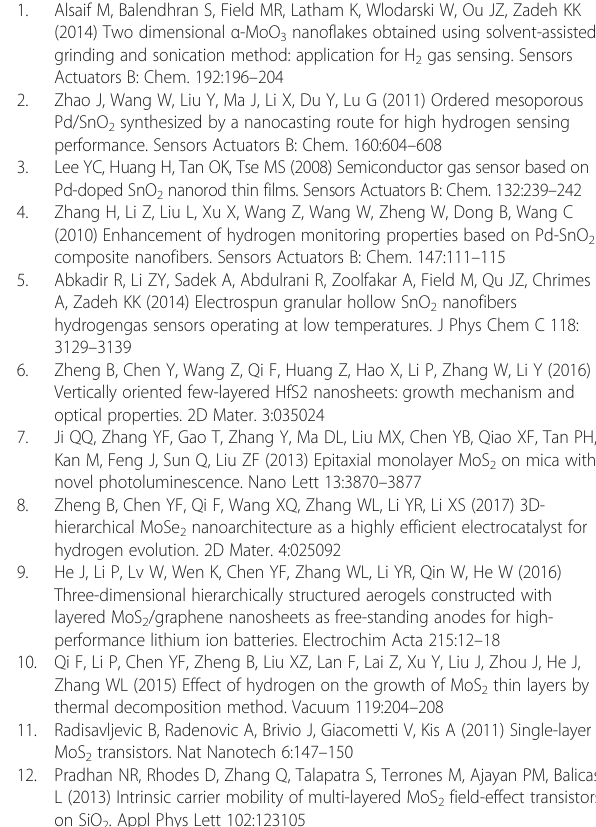
Additional file 1: Figure S1. AFM images of the Pd-decorated MoS 2 films with the Pd thickness of (a) d Pd =1 nm, (b) d Pd =3 nm, (c) d Pd =5 nm, (d) d Pd =10 nm, (e) d Pd =15 nm and (f) d Pd =30 nm. Figure S2. UV spectrum of the few-layer MoS 2 film. Figure S3. Sensing curves of (a) the few-layer MoS 2 /SiO 2 /Si heterojunction and (b) 5-nm Pd/SiO 2 /Si heterojunction. (DOCX 1723